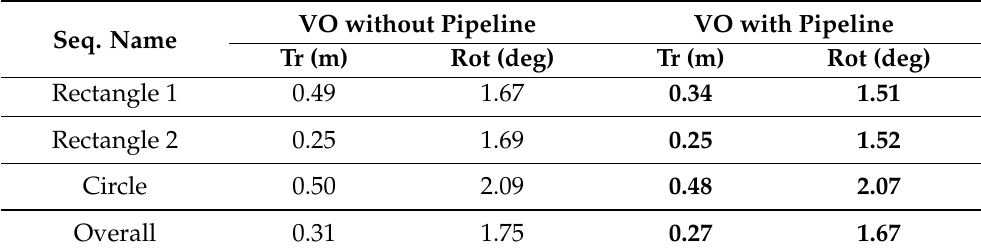
Table 6. Summit accuracy comparison.